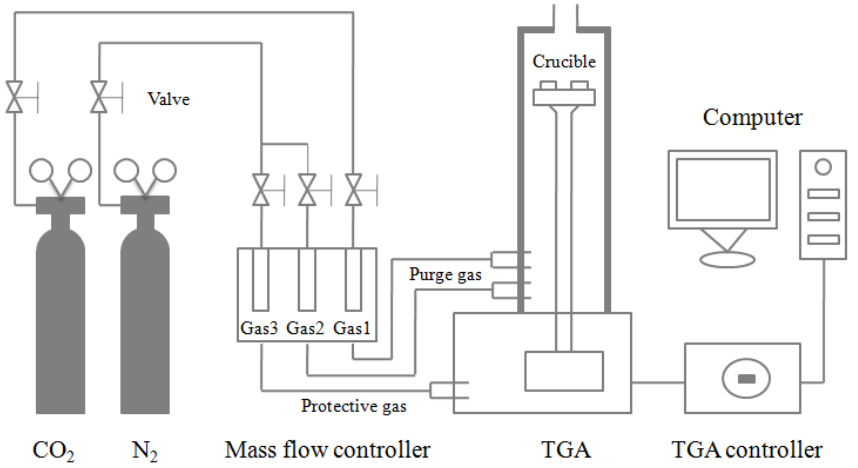
Figure 1. Schematic of STA409 PC.